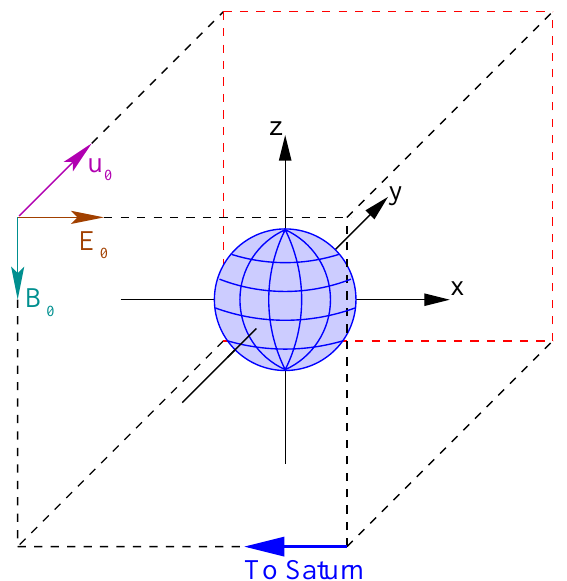
Fig. 16. Titan’s plasma environment at 00:00 Saturnian local time – simulation geometry. Again, the x axis is pointing from the sun to Titan, whereas the undisturbed magnetic field is orientated antipar- allel to the z axis. The undisturbed plasma flow is directed in ( + y) direction and yields a convective electric field that is parallel to the x axis, pointing away from